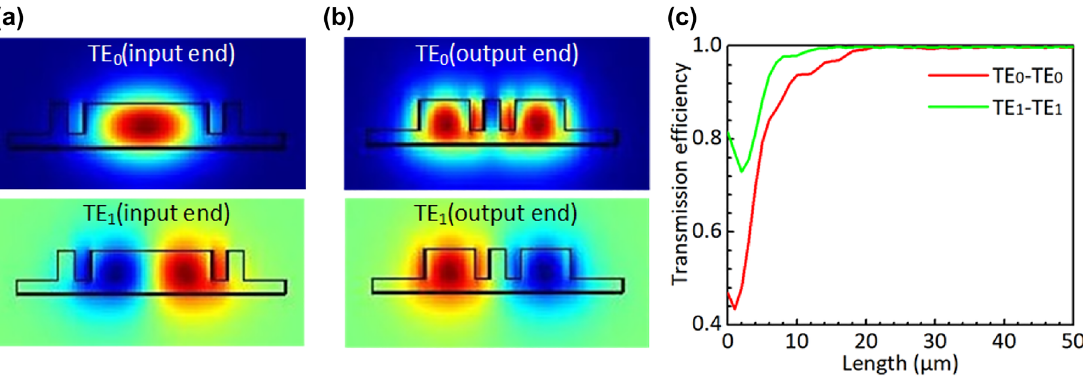
Figure 4: The mode profiles of the TE 0 and TE 1 modes at the input end (a) and the output end (b) of the triple-core waveguide of the PS.